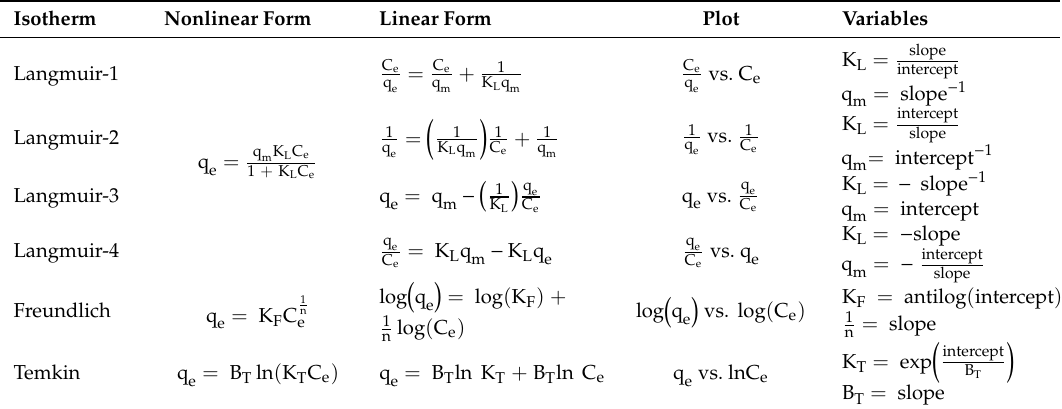
Table 3. List of adsorption isotherms models used in this study and their nonlinear and linear forms. Isotherm Nonlinear Form Linear Form Plot